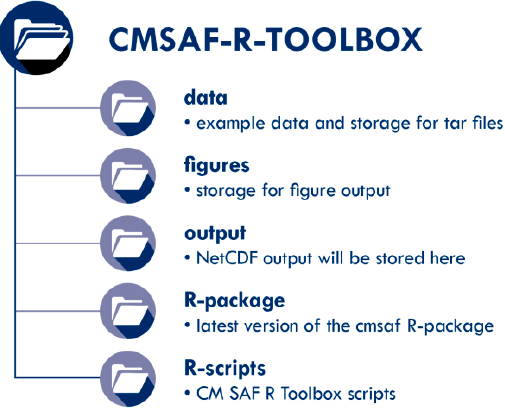
Figure 1. CM SAF R Toolbox folder structure.